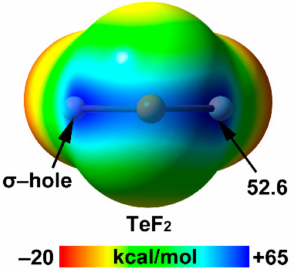
Figure 10. MEP surfaces of TeF 2 using the 0.001 a.u. isosurface and the MP2/def2-TZVP level of theory (energy in kcal/mol).